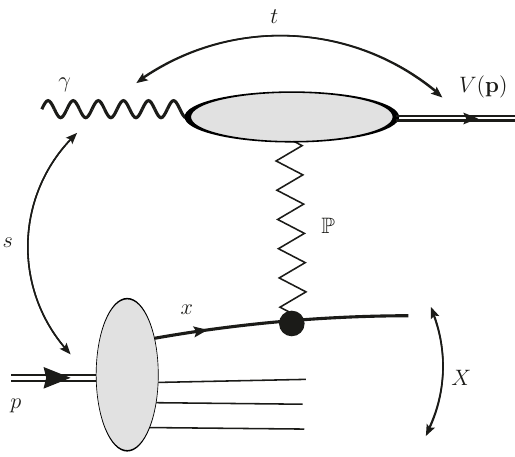
Figure 1 . Di(cid:11)ractive photoproduction of a vector meson V . The zigzag line corresponds to a perturbative Pomeron coupling to individual partons inside the